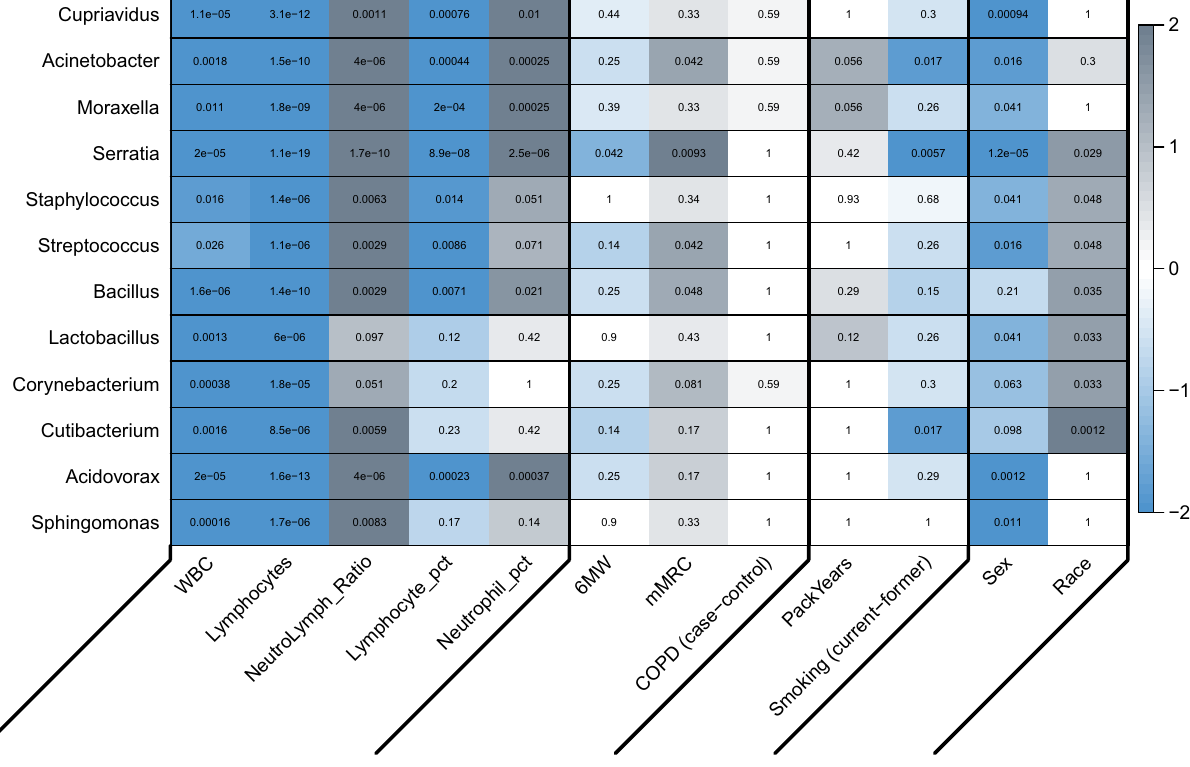
Figure 2. Heatmap of the associations between genera inferred abundance and host-related variables for the meta-analysis. Variables with at least one finding with FDR < 10% were included. The value in each cell is the adjusted q-value. The color scale for the cells represents the sign of the effect multiplied by negative log 10 of the q-values, with intensity proportional to significance and gray shading representing positively correlated associations and blue shading representing negatively correlated associations. Results with discordant directions of effect in the meta-analysis are set to q = 1 (white) (heatmap produced using the labeledHeatmap function from the R package WGCNA 45 ). Variables with at least one significant association are included (WBC = white blood cell count, Lymphocytes = lymphocyte count, NeutroLymph_Ratio = ratio of neutrophil counts to lymphocyte counts, Lymphocyte_pct = percentage of lymphocytes, Neutrophil_pct = percentage of neutrophils, 6 MW = six-minute walk distance, mMRC = Modified Medical Research Council dyspnea score, COPD (case–control) = COPD cases vs. controls, PackYears = pack-years history of smoking, Smoking (current- former) = current vs. former smoking